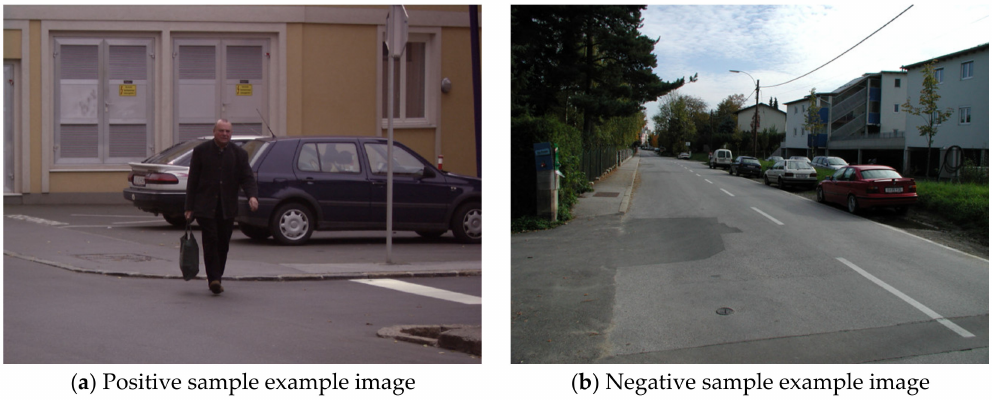
Figure 3. The sample example image of INRIA person